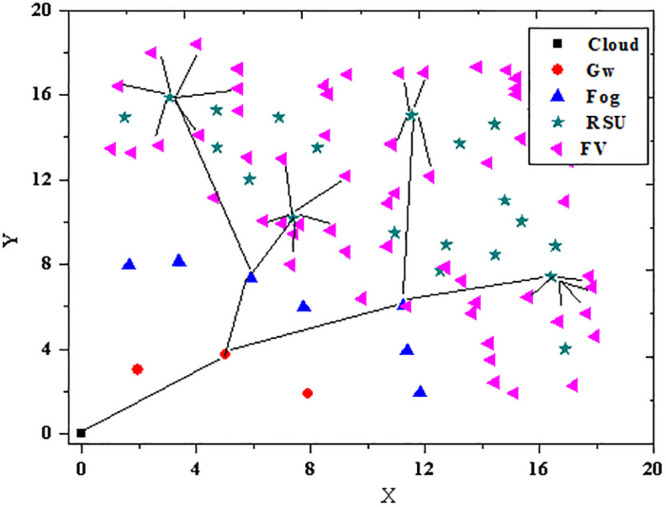
ND analysis of Scenario B.